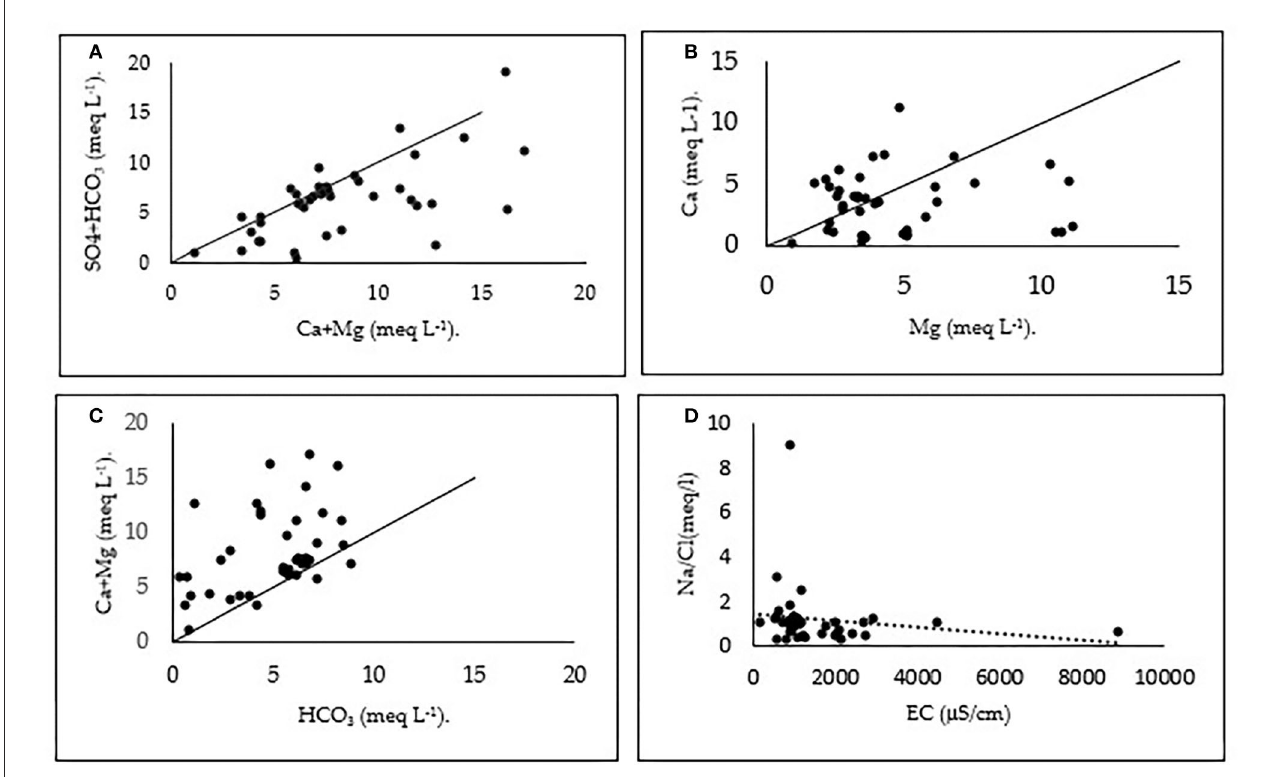
FIGURE8 Plots of (Ca 2 + + Mg 2 + ) vs. (HCO − 3 + SO 2 − 4 ) (A) , Mg 2 + vs. Ca 2 + (B) , HCO 3 vs. (Ca 2 + + Mg 2 + ) (C) , and EC versus Na/Cl (D) .